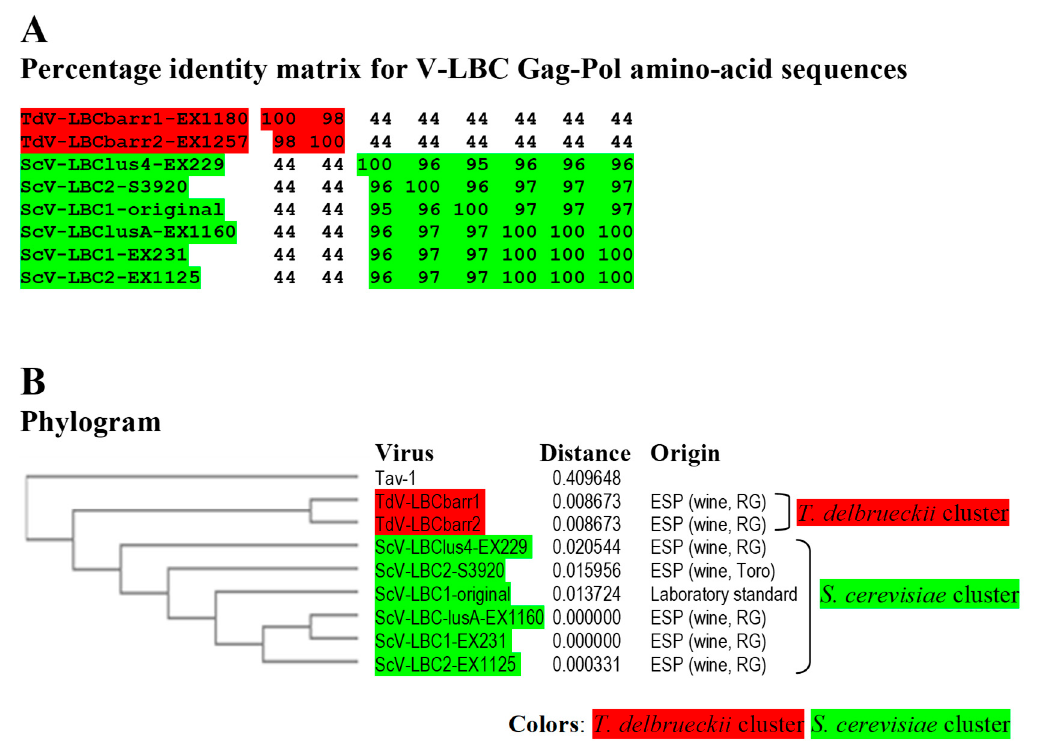
Figure 5. Phylogenetic relationship of yeast LBC viruses. ( A ) Percentage identity matrix between the complete amino acid sequences of the Gag-Pol proteins of LBC viruses. Each identity value was rounded to the nearest whole number. ( B ) Phylogram with evolutionary distances (given by the MUSCLE program) and geographical location at which each killer yeast strain was isolated. RG, Ribera del Guadiana region in Extremadura. ESP, Spain. Viruses included in each of the two main clusters, as well as their identity values, are shaded in red or green. The Tuber aestivum (Tav-1) totivirus was used as outgroup (GenBank accession number